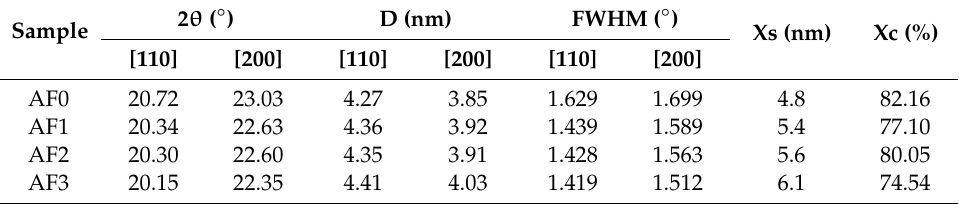
Table 4. Comparison of crystalinity structure parameters of aramid fiber before and after treatment.